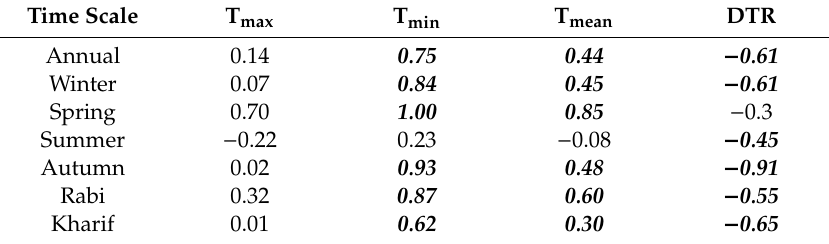
Table 2. Absolute changes in temperature ( ◦ C) indices in Punjab Province during the second period